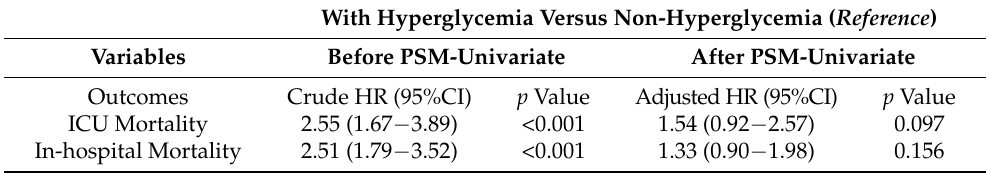
Table 2. Association between outcomes and hyperglycemia among patients with ischemic stroke. With Hyperglycemia Versus Non-Hyperglycemia ( Reference ) Variables Before PSM-Univariate After PSM-Univariate